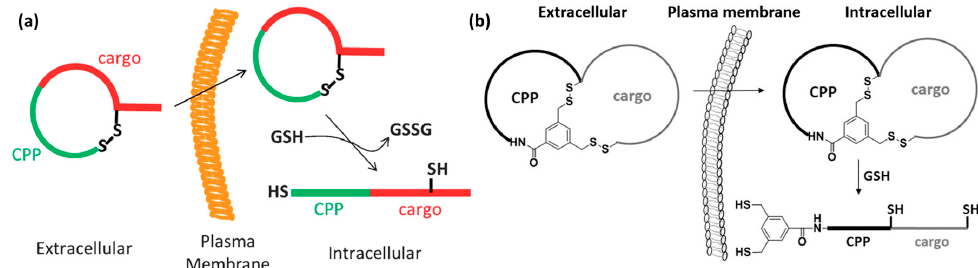
Figure 9. Schematic representations of reversible ( a ) cyclic (cyclization through a disulfide bridge) and ( b ) bicyclic (cyclization through a pair of disulfide bonds) CPPs that undergo reduction upon exposure to glutathione in an intracellular environment, used with permission from references [133] (Copyright © 2015 Wiley) and [138] (Copyright © 2017 Wiley), respectively.